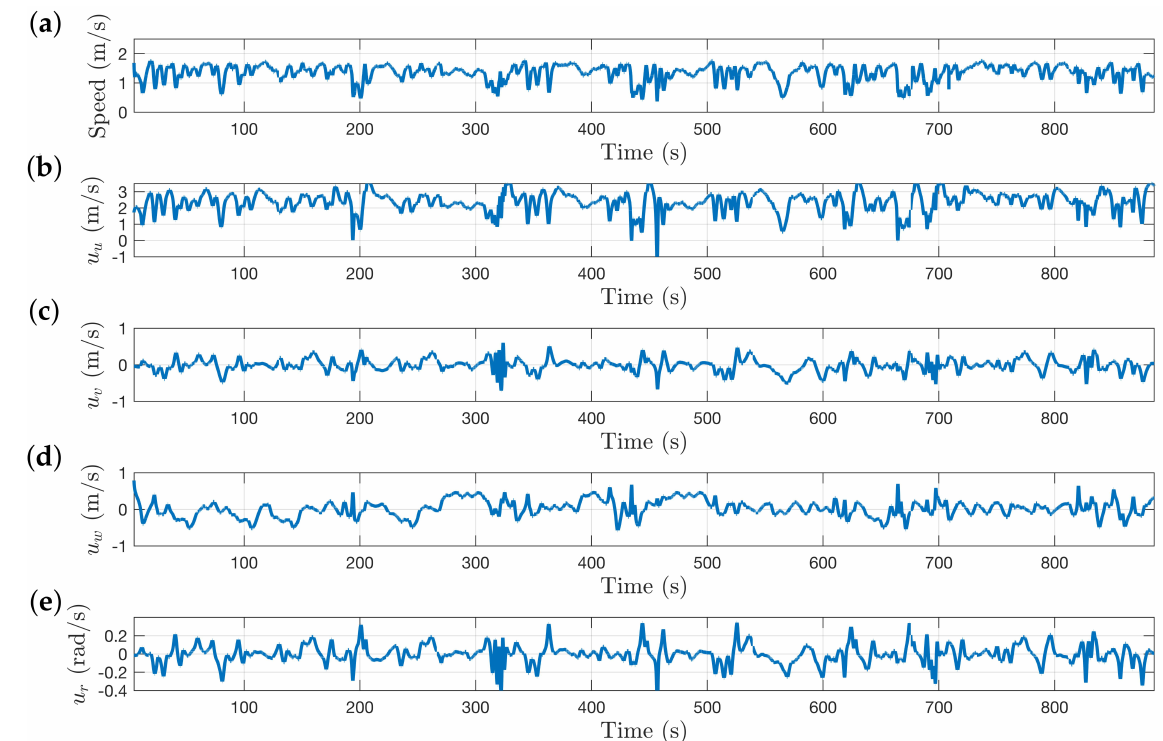
Figure 16. Plots showing speed of system and control commands as it navigates through environment shown in Figure 15. ( a ) Speed of the system. ( b ) Forward speed command. ( c ) Lateral speed command. ( d ) Vertical speed command. ( e ) Yaw rate